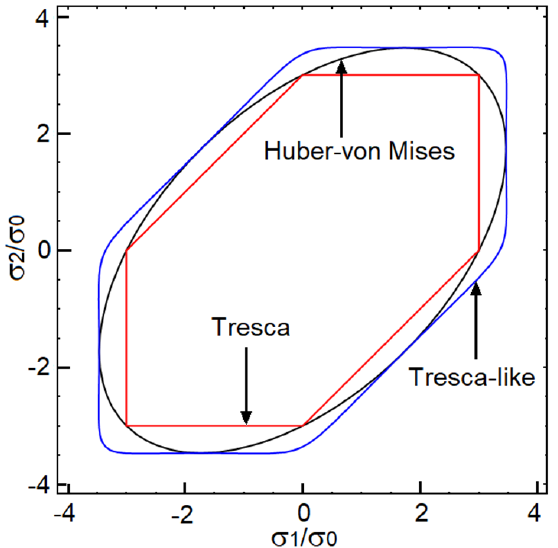
Figure 1. Yield stress plotted on the stress plane ( σ 1 , σ 2 ) , where σ 3 = 0. The original Tresca criterion (red line) is obtained for α = 2 and β 0 = 0. The Huber–von Mises criterion (black line) is found from setting β 0 = 1. In the Tresca-like yield criterion β 0 = 1/2, and the line is colored blue.